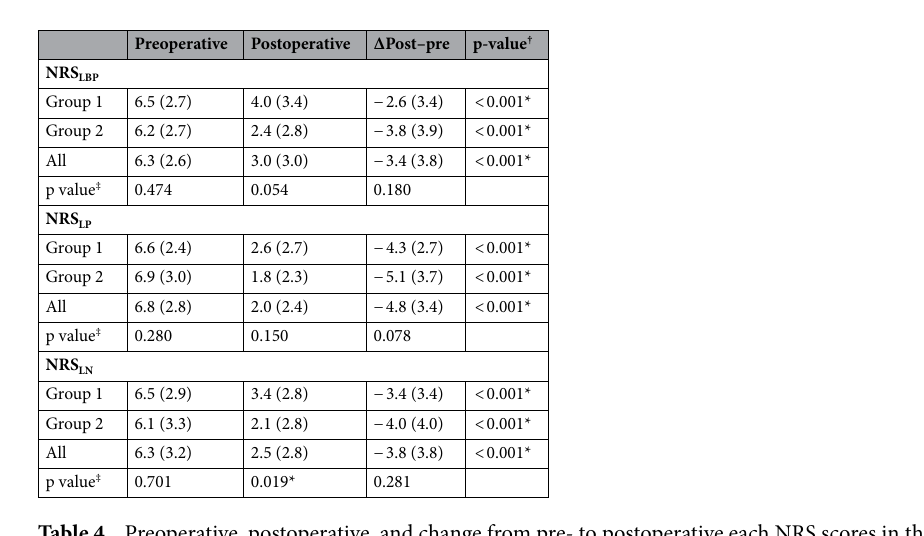
Table 4. Preoperative, postoperative, and change from pre- to postoperative each NRS scores in the two groups. NRS numeric rating scale, NRS LBP NRS for low back pain, NRS LP NRS for leg pain, NRS LN NRS for leg numbness. † Comparison with pre op. ‡ Comparison between two groups. *Statistically